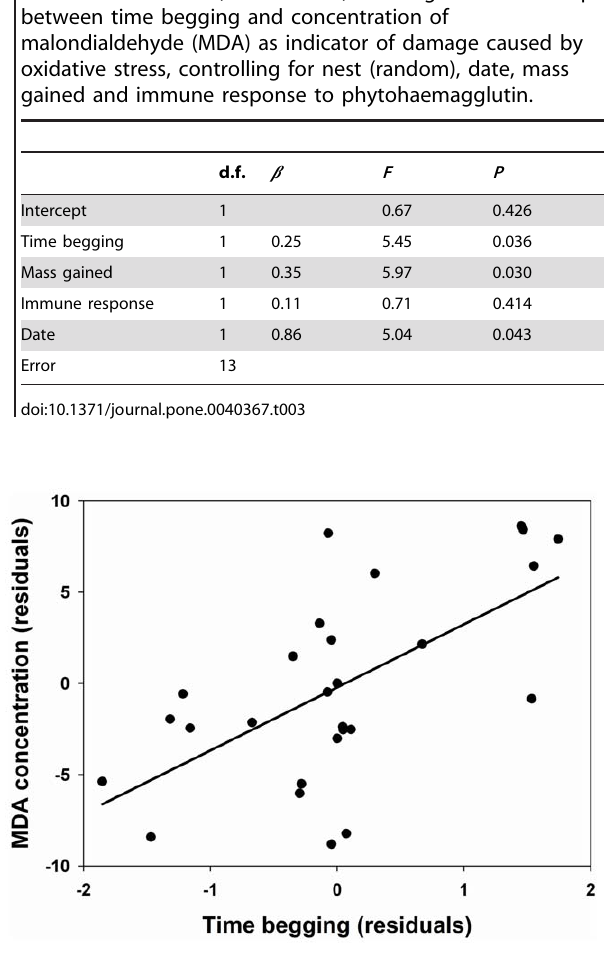
Figure 2. Relationship between MDA concentration (lipid peroxidation) and begging time. The residuals, after controlling for mass gained, immune response to phytohaemagglutinin, nest (random), and date, are shown. The regression line is